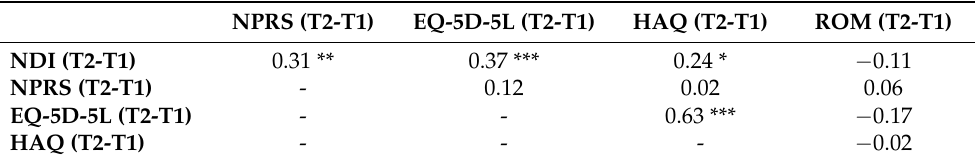
Table 3. Correlations of PROs and ROM delta scores ( T 2 − T